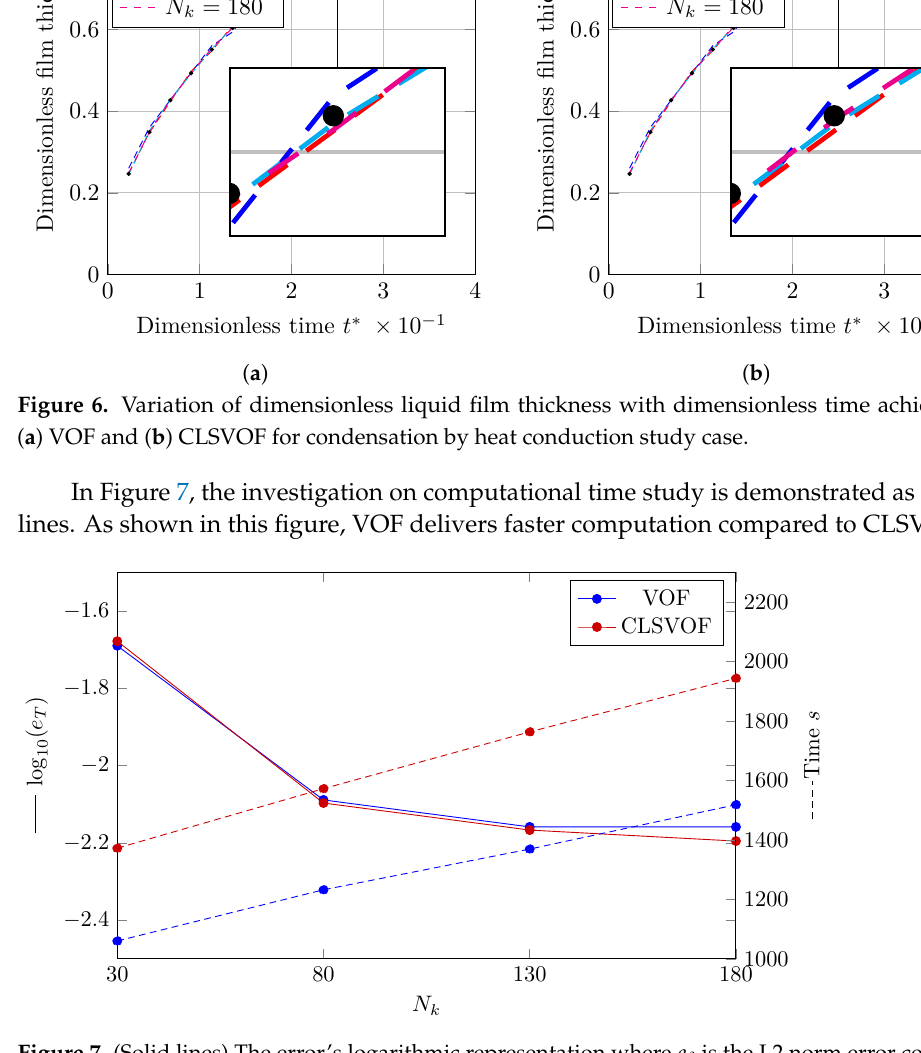
Figure 7. (Solid lines) The error’s logarithmic representation where e δ is the L2 norm error computed by Equation (24). (Dashed lines) VOF and CLSVOF computation times for the condensation by heat conduction case problem at various grid sizes. The number of nodes along the x axis is represented by the horizontal axis ( N k